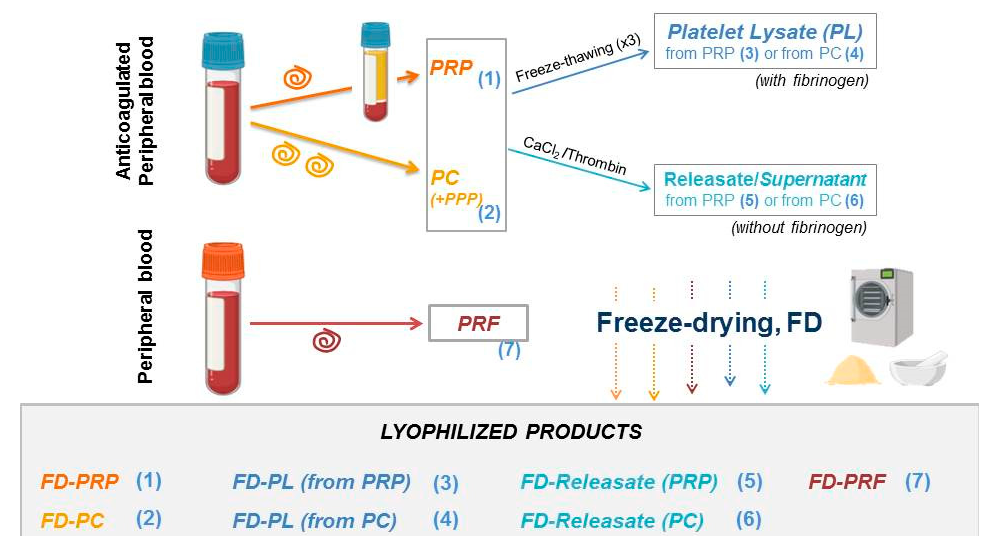
Figure 2. Preparation of different plasma formulations for lyophilization. Single spinning of anticoagulated whole blood yields platelet ‐ rich plasma ( PRP) with moderate concentration of platelets (and optionally leukocytes), for the purpose of this study designed as (1); alternatively, double spinning or plateletpheresis systems produce platelet concentrates (PCs) designed as (2). The pellet can be resuspended in a determined volume of Platelet ‐ Poor Plasma (PPP) and platelet count adjusted, or platelets can be used without plasma. When PRP or PC products are freeze ‐ thawed multiple times (commonly 3) or sonicated, the resultant platelet lysates (PLs) contains platelet secretome along with platelet membranes (ghost platelets) designed as (3) and (4), respectively. Alternatively, the platelet secretome can be obtained after the activation of platelets by adding calcium chloride/ thrombin. The supernatant released from the clot (from PRP (5) or PCs (6)) contains the whole platelet secretome. PRF (7) is obtained by centrifuging noncoagulated peripheral blood and disposing of the formed hydrogel the red blood cells. Terminology: PRP, platelet ‐ rich plasma; PC, platelet concentrate; PPP, platelet ‐ poor plasma; PL, platelet lysate; PRF, platelet ‐ rich fibrin; FD ‐ PRP, freeze ‐ dried platelet ‐ rich plasma; FD ‐ PC, freeze ‐ dried platelet concentrate; FD ‐ PL, freeze ‐ dried platelet lysate; FD ‐ PRF, freeze ‐ dried platelet ‐ rich fibrin. In lyophilized products from group (A), the platelet membrane should be undamaged after the freeze ‐ drying process [7]: changes in size distribution, altered morphology by SEM, biomarker pattern in flow cytometry, and response to agonists after platelet rehydration are therefore assessed. In this context, platelets can be preserved by introducing trehalose, a commonly used lyoprotectant, into their cytosol, and freeze ‐ drying in trehalose/albumin buffer [10]. Trehalose is also efficient as an extracellular lyoprotectant, preventing protein aggregation and enhancing plasma stability during storage, and is preferred over sucrose and glucose [11].